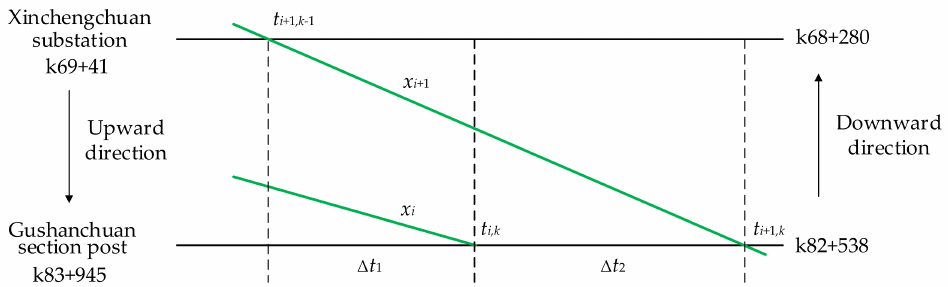
Figure 10. Section train operation diagram from 12:32:44 to